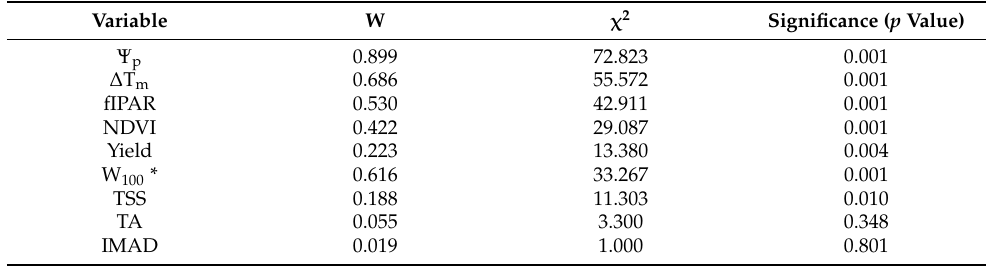
Table 5. Kendall’s coefficient of concordance (W) computed over the years of study. Variables are predawn water potential ( Ψ p ), canopy to air temperature difference ( ∆ T m ), fractional intercepted PAR (fIPAR), Normalized Difference Vegetation Index (NDVI), Yield, weight of 100 berries (W 100 ), Total Soluble Solid (TSS), Total acidity (TA) and maturity index